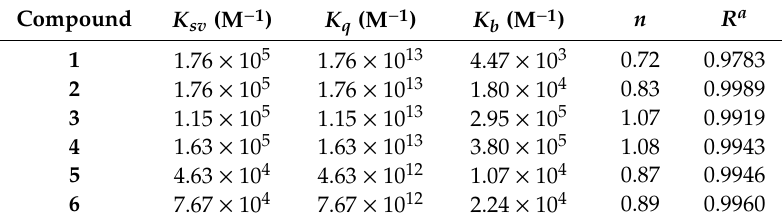
Table 2. Quenching constants and binding constants of compounds 1 – 6 with BSA.